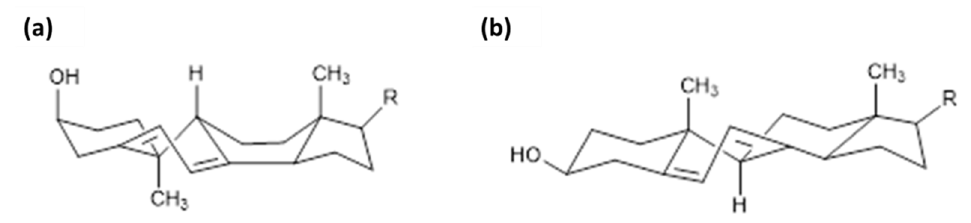
Figure 5. Configurations of lumisterol ( a ) and provitamin D ( b ).